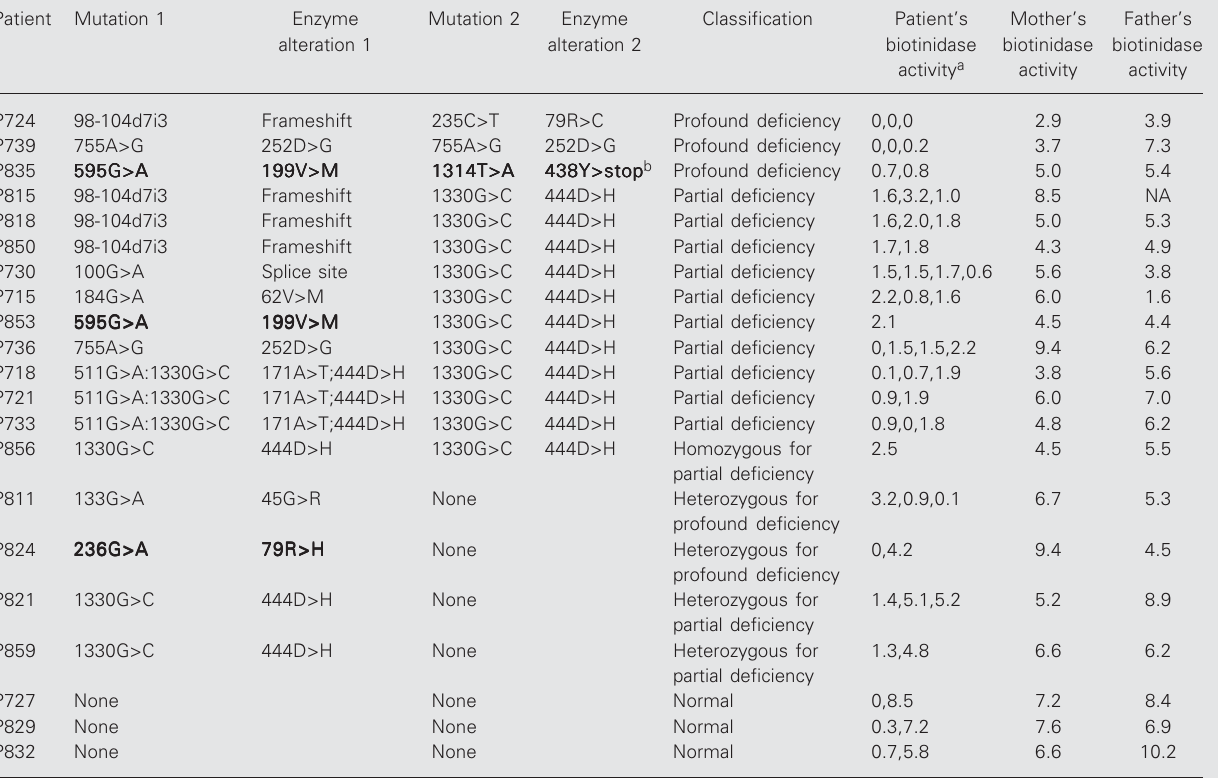
Table 1. Biochemical and molecular characterization of children suspected of having biotinidase deficiency by newborn screening. Patient Mutation